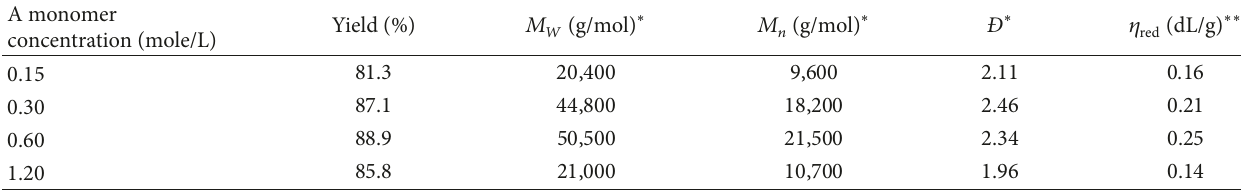
Table 5: The influence of the solution concentration (per a monomer) on the characteristics of PE8E4. A monomer concentration (mole/L)